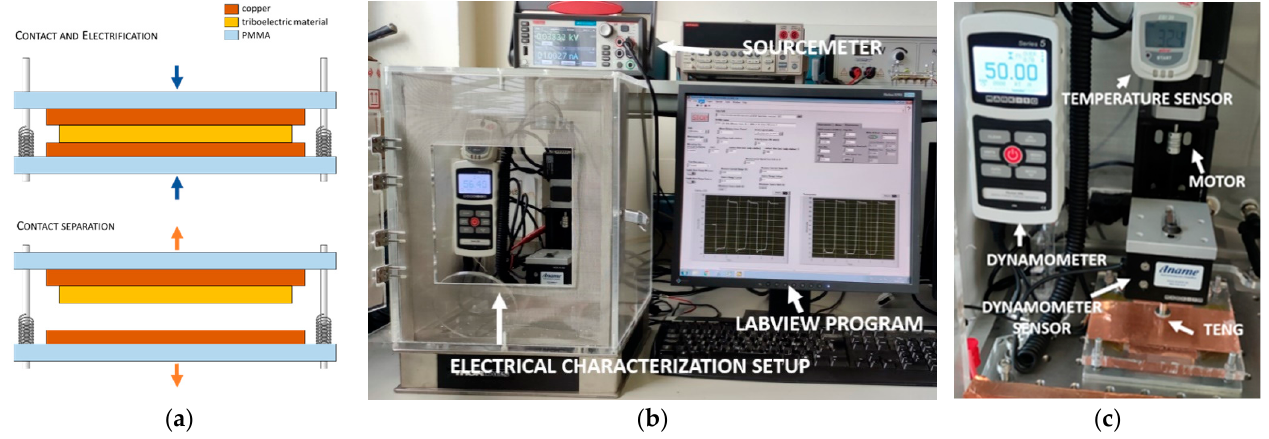
Figure 2 . ( a ) Schematic of material and electrode used for the characterization of the materials; ( b , c ) ad hoc setup for electromechanical characterization of triboelectric devices.